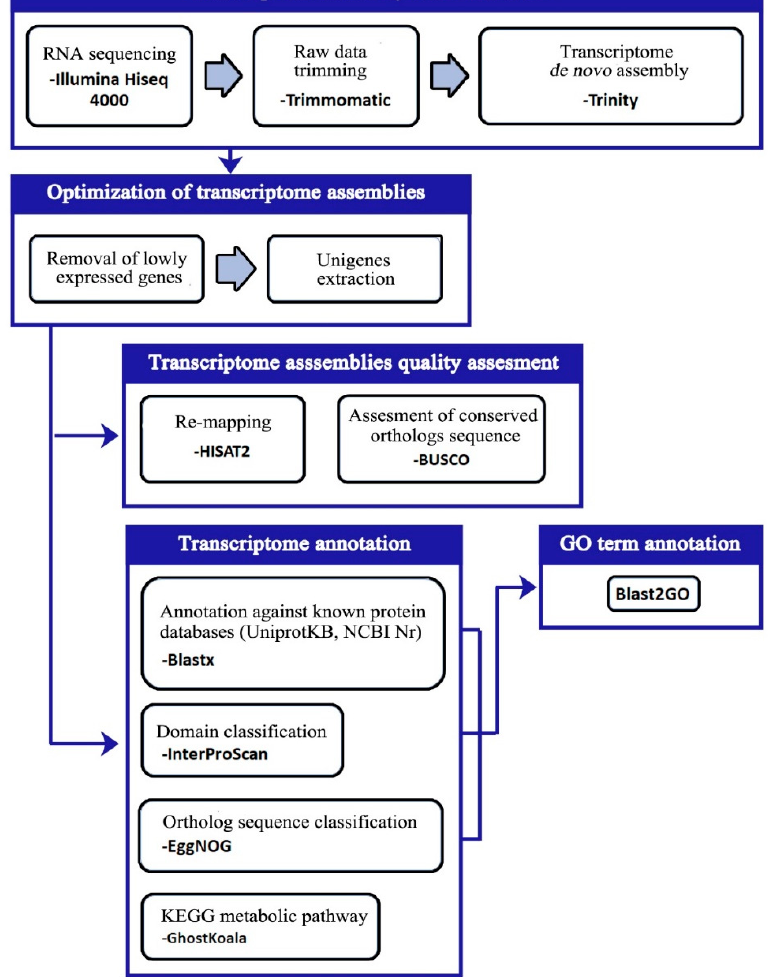
Figure 1. Flow chart of A. minutum transcriptome analysis method used in this study.